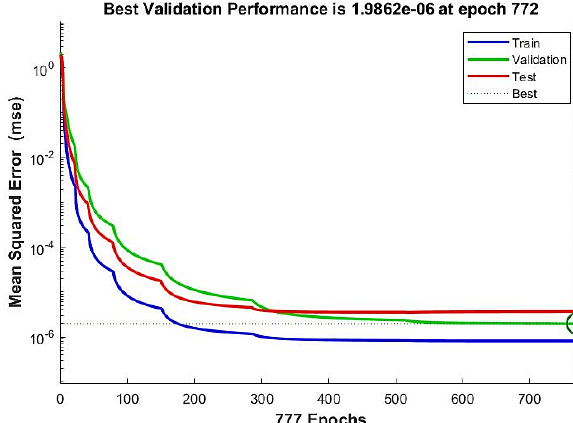
Fig. 7. Error histogram